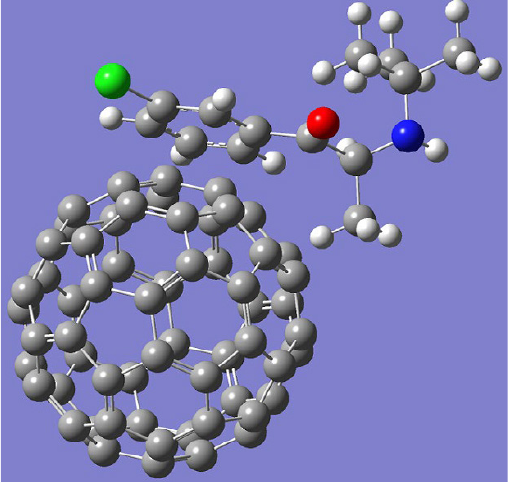
Fig 5. The output of Bupropion-C60 complex Fig. 5. The output of Bupropion-C60